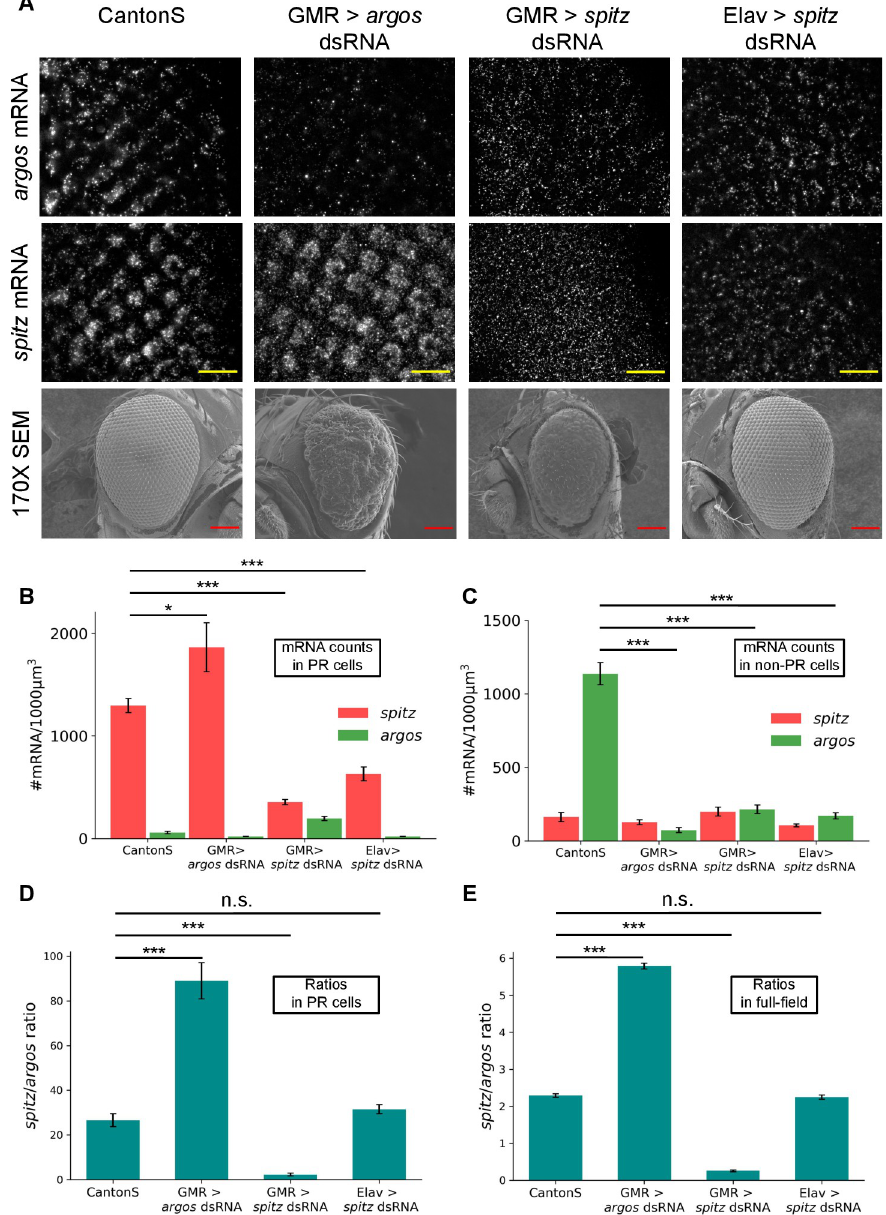
Fig 2. spitz- to- argos ratio is important for proper ommatidial patterning. (A) smFISH was performed in eye imaginal discs from represented crosses for spitz and argos mRNA in the two rows. In the third row, adult eye phenotypes are shown. The Elav > UAS spitz dsRNA progeny shows perfectly arranged ommatidia like the wildtype CantonS, while the other two crosses show rough eye phenotypes. Scale bar for widefield fluorescence images is 10 μ m and SEM images is 100 μ m. (B) and (C) mRNA numbers for spitz and argos were counted in photoreceptors and non- photoreceptors in respective crosses. spitz in PR cells and argos mRNA in non-PR cells show variation in number as expected from the respective crosses ( spitz expression has p-value > 0.05 ( � ) in a Student’s t-test when compared between CantonS and GMR-Gal4 driving spitz dsRNA. Other comparisons of spitz expression in PR cells and argos expression in non-PR cells are highly significant with p-values < 0.001 ( ��� ) in a Student’s t-test). spitz -to- argos mRNA ratio in the photoreceptor cells (D) was calculated as dosage was known to be important for ommatidial pattern formation (N = 9 tissues in all the crosses). Most remarkably, knocking down spitz in PR cells with a Elav driver, knocks down argos numbers too, and overall the ratio is unchanged. When a GMR driver is used to knockdown either argos or spitz in the full field, the ratio is higher or lower than wildtype. spitz -to- argos ratio in the eye field irrespective of cell type (PR or non-PR) did not show any difference and is used henceforth in the paper (E). spitz -to- argos